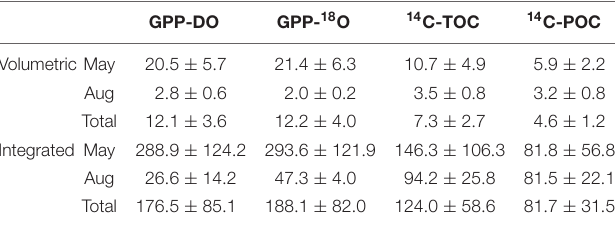
Values shown indicate rates separated by season (May, August) as well as the aggregate of all data (Total). 14 C-DOC production is calculated by subtracting 14 C- POC from 14 C-TOC (data in Supplementary Table S1